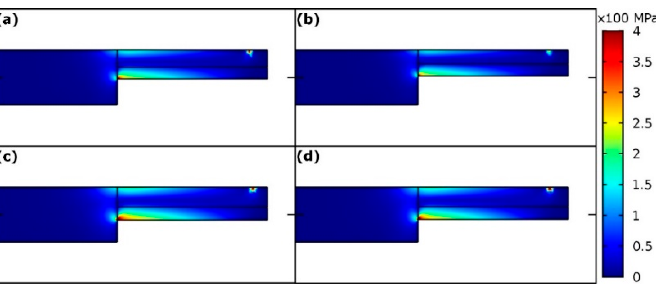
Figure 5. Von Mises stress distribution (in MPa) in the vertical mirror plane of microcantilevers A–D ( a – d ), respectively. Cantilever deflection equals 0.4 μ m. Table 4. The calculated elastic strain energy density in the fixed bottom corner, calculated total elastic strain energy, and the calculated {measured} forces belonging microcantilevers A, B, C, and D, assuming deflection equals 0.4 µ